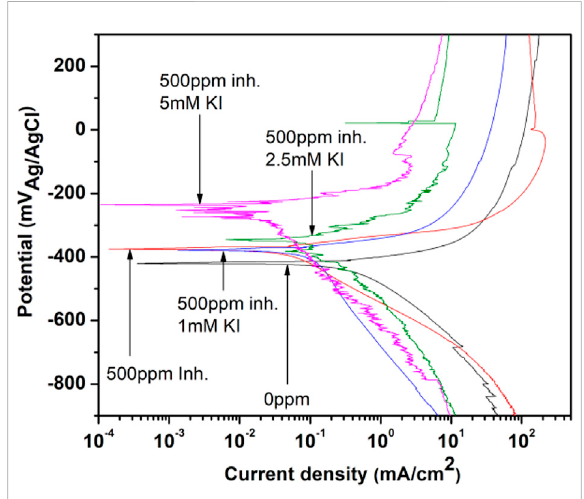
FIGURE 8 Polarization curves for 1018 steel corrosion inhibition with 500 ppm of M. sativa and different KI